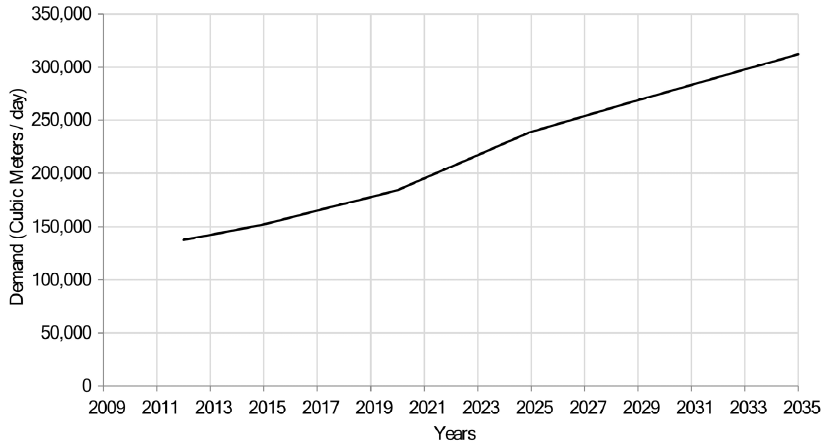
Figure 2. Water demand projections for Mombasa City [34].